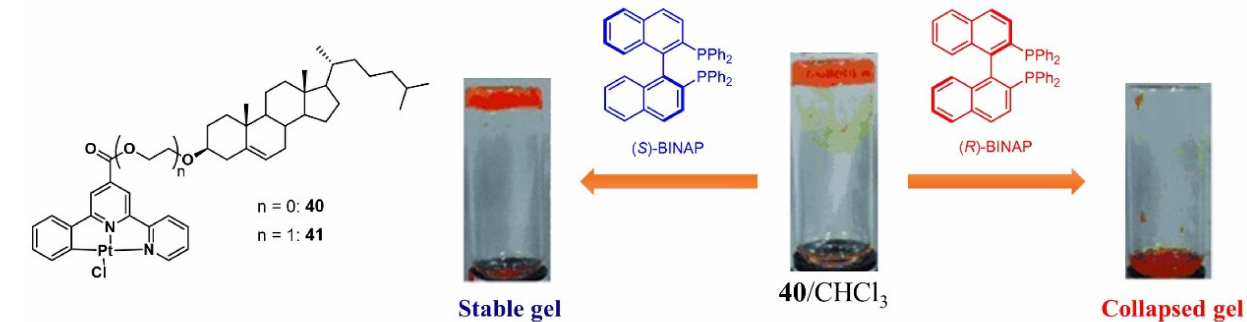
Figure 17. Visual chiral recognition of ( R )- and ( S )-BINAP through gel 40 /CHCl 3 (1 wt%) enan- tioselective collapsing. Reprinted with permission from Ref. [76]. Copyright (2011), John Wiley and